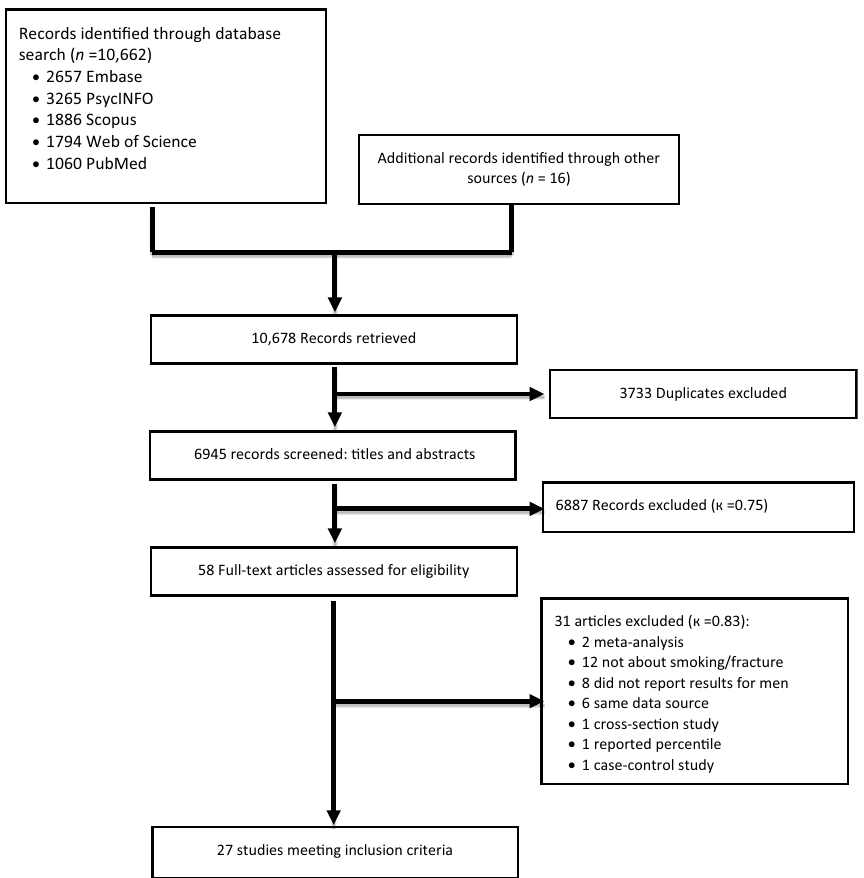
Figure 1. Study Selection for